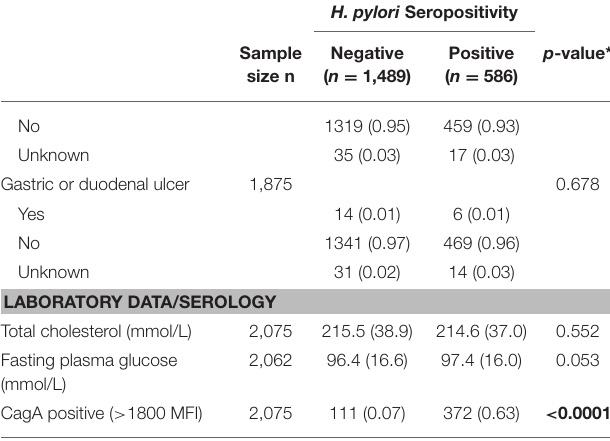
TABLE 1 | Frequency (%) and mean (SD) of characteristic variables by H. pylori seropositivity status at the F4 survey in persons who participated in both surveys ( n =